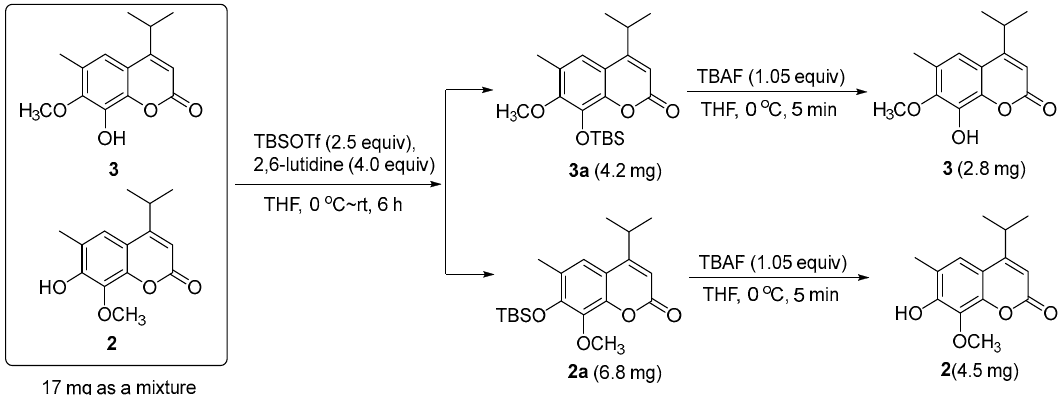
Figure 4. Silicon etherification involved the isolation of 2 and 3 .